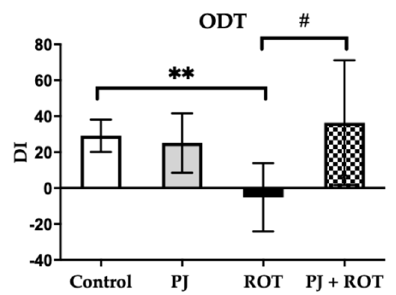
Figure 3. Effect of pomegranate juice treatment (PJ) on olfactory discrimination task (ODT) expressed as olfactory discrimination index (DI) in rotenone (ROT)-injected rats. Data are presented as mean values ± SEM of eight rats per group and analyzed using one-way analysis of variance (ANOVA) followed by Fisher’s LSD test. ** p < 0.01 vs. Control. # p < 0.05 vs.